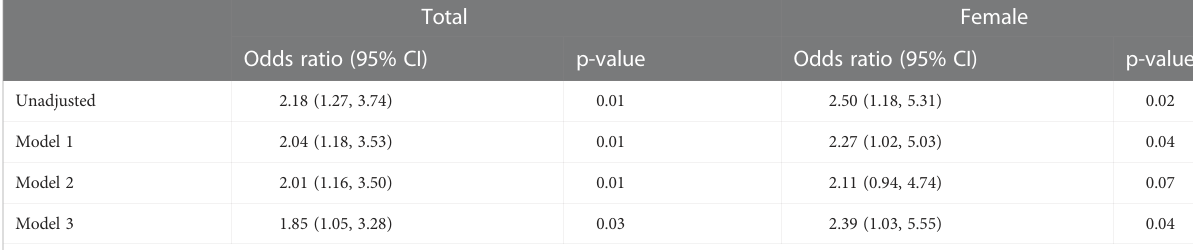
NAFLD, nonalcoholic fatty liver disease; CI, con fi dence interval; NFPA, nonfunctioning pituitary adenoma. Model 1: adjusted by age. Model 2: adjusted by age, preoperative total cholesterol. Model 3: adjusted by age, preoperative total cholesterol, hypogonadism, and prolactin level.